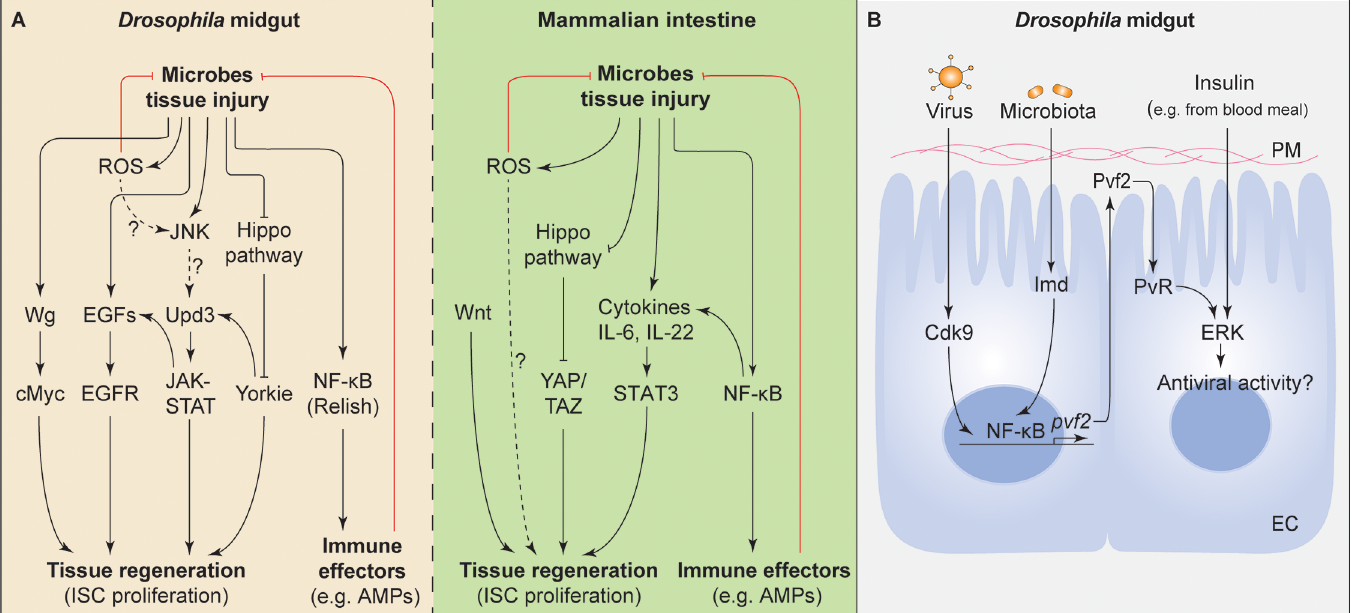
Fig 2. A conserved gene regulatory network controls tissue homeostasis in flies and mammals. ( A ) In both flies and mammals, the gut epithelium producesimmune effectors, includingreactive oxygen species (ROS) and antimicrobial peptides (AMPs). Epithelialcells and immune cells secrete cytokines that stimulate tissue regeneration. The Hippo pathwayis a conservedregulatorof intestinalstem cell (ISC) activity. In Drosophila , activationof the JAK-STAT pathway by the cytokine Unpaired 3 (Upd3) triggers the releaseof epidermalgrowth factors (EGFs) by the stem cell niche, which then inducesstem cell proliferation. JAK-STAT activation also directly stimulates ISC proliferation and differentiation. The Wingless (Wnt/Wg) pathwayis a major regulatorof ISC proliferation in mammals and also promotes tissue regeneration through cMyc in the infected Drosophila midgut. The dashed arrows indicate presumed activities but as yet are undefined. ( B ) Gut microbes and viruses coordinatelystimulate a PDGF-VEGF Receptorand Extracellular Signal-Regulated Kinase dependent(pvf2/PVR/ERK) antiviral responsethrough the Immune Deficiency (Imd) pathwayand Cyclin-dependent-kinase 9 (Cdk9) induction,respectively, in the midgut of Drosophila . The ERK-stimulated antiviral activities/effectors have not been determined. In addition,exogenous insulininitiates ERK mediated antiviral activity.